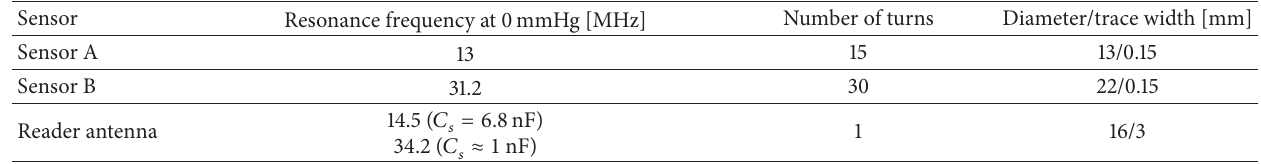
Table 1: Characteristics of the sensors and reader